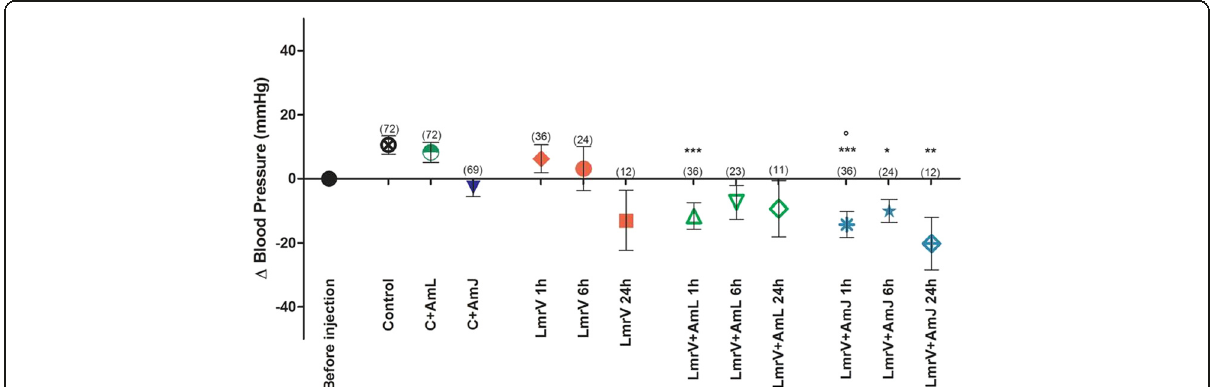
Fig. 4 Variation of systolic blood pressure during 24 h after the envenomation with Lachesis muta rhombeata venom (LmrV) and their respective treatments with aqueous extract of Annona muricata L. leaves (LmrV + AmL) or Annona muricata L. juice (LmrV + AmJ). The animals, male Wistar rats, were injected with 3 mg of Lachesis muta rhombeata venom and the blood pressure was measured before the venom injection and at 1, 6 and 24 h after the envenomation. The numbers above the columns represent the number of animals used in each